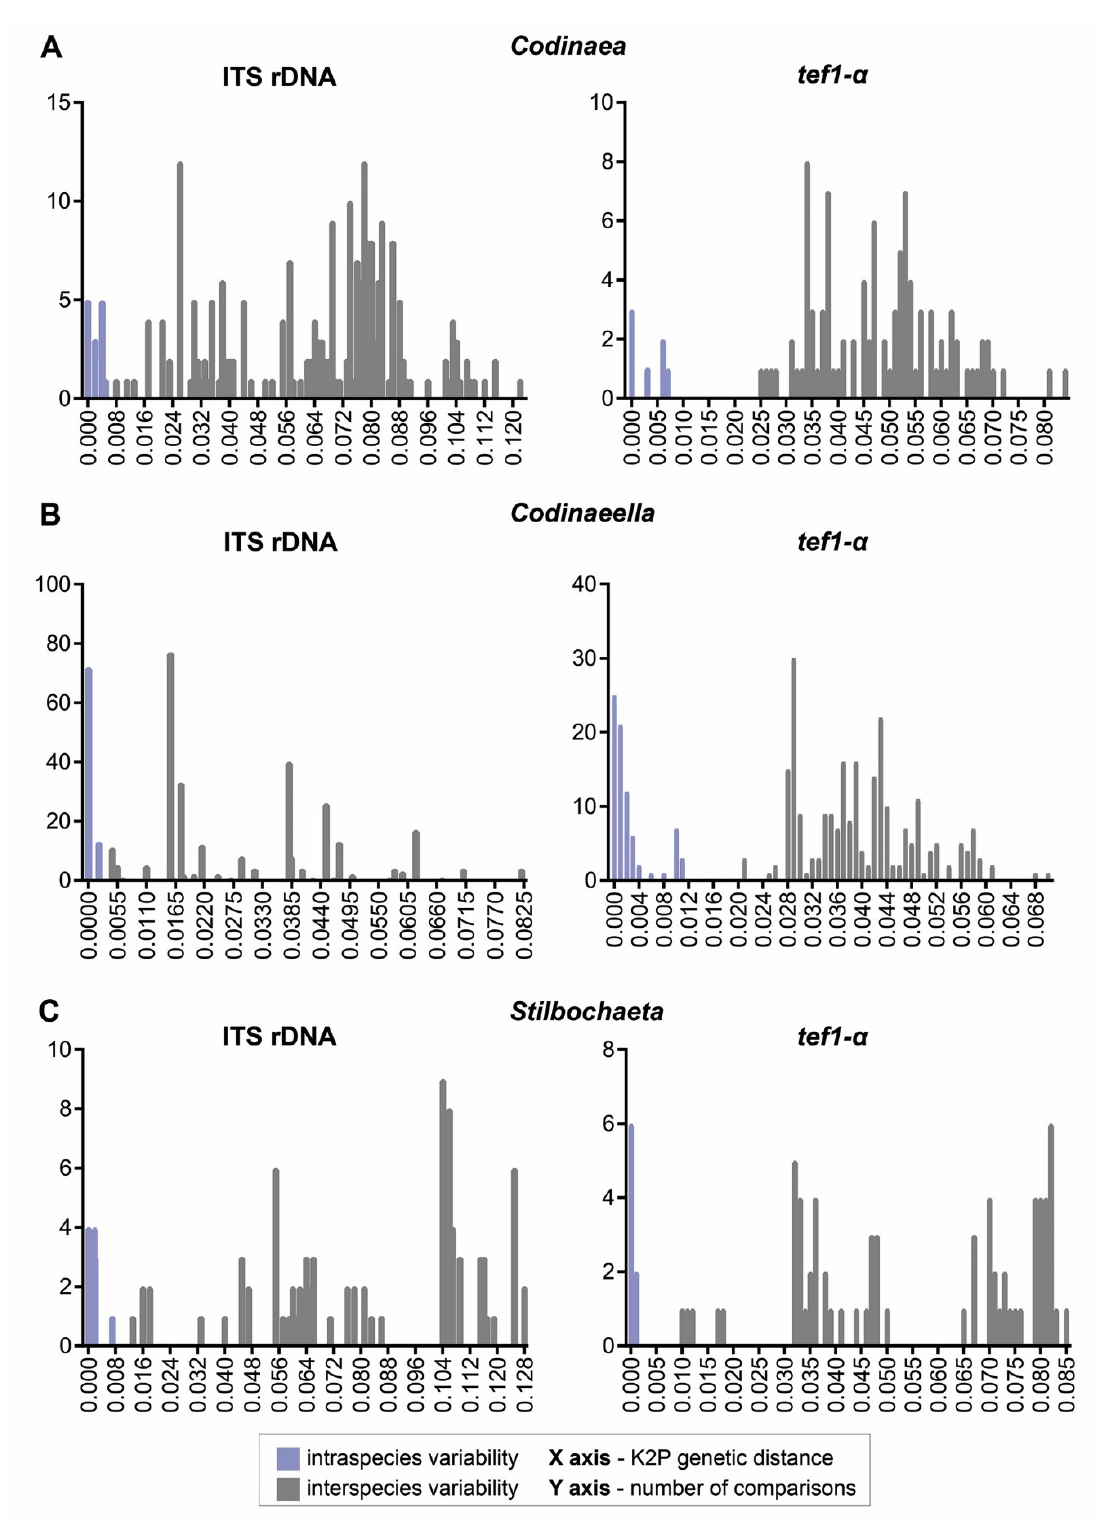
Figure 3. The frequency distribution graphs of the Kimura 2-parameter distances of ITS and tef1- α DNA sequences (barcoding gaps). ( A ) Codinaea ; ( B ) Codinaeella ; ( C ) Stilbochaeta . The intraspecific distances are shown as blue bars and interspecific distances as grey bars. The bin size of 0.001 and 0.0005 (only ITS, Codinaeella ) were used.